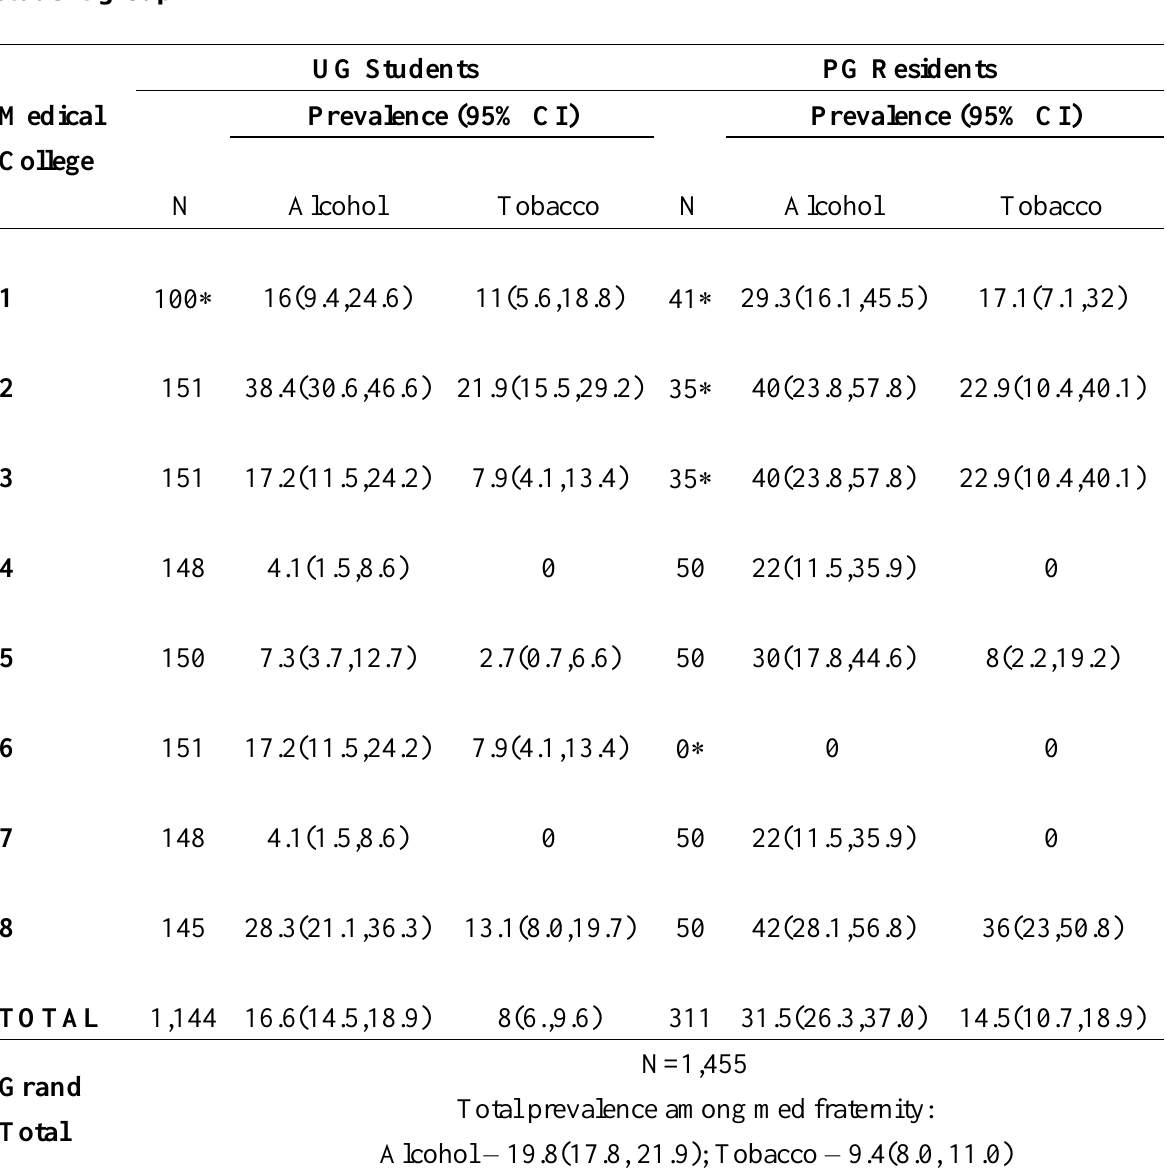
Table 1: Distribution of alcohol and tobacco use among participants stratified by college and student